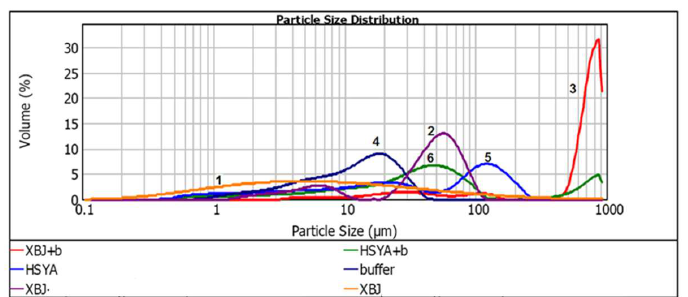
Molecules 2017 , 22 , 2129 Table 5. d(0.1), d(0.5) and d(0.9) values of particle size distribution of HSYA and XBJ in aqueous solution and alkaline buffer.